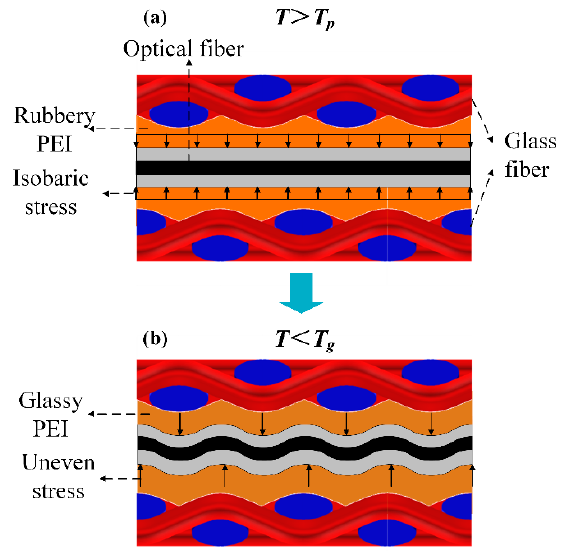
Figure 13. Principle of the bending induced reflectivity change in the pigtail ( a ) above Tp and ( b ) below Tg .